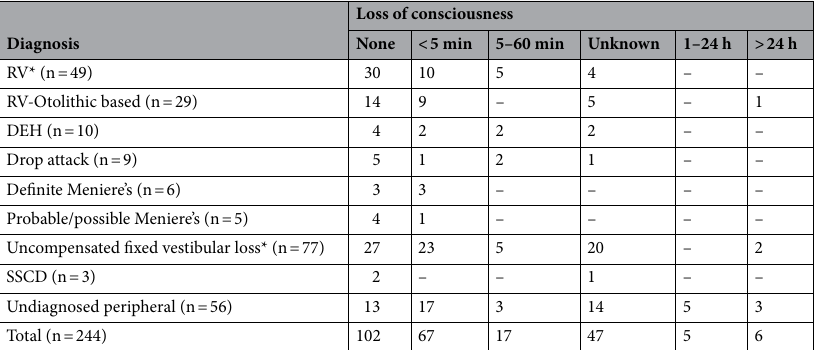
Table 4. Loss of consciousness following head trauma in the presenting types of peripheral vestibular disorders. *Significant difference (p < 0.05) in duration of LOC in RV vs. uncompensated fixed vestibular loss. RV recurrent vestibulopathy, SSCD superior semicircular canal dehiscence, DEH delayed endolymphatic hydrops. Undiagnosed peripheral disorder represented those with a history suggestive for peripheral vestibular dysfunction but defied classification into a recognized subgroup according to symptoms/signs/duration of vertigo